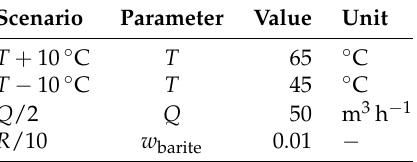
Table 3. Varied parameters in the respective scenarios for a one-at-a-time sensitivity analysis. Decreasing Q and w barite corresponds to decreasing flow velocity and precipitation rate, respectively.